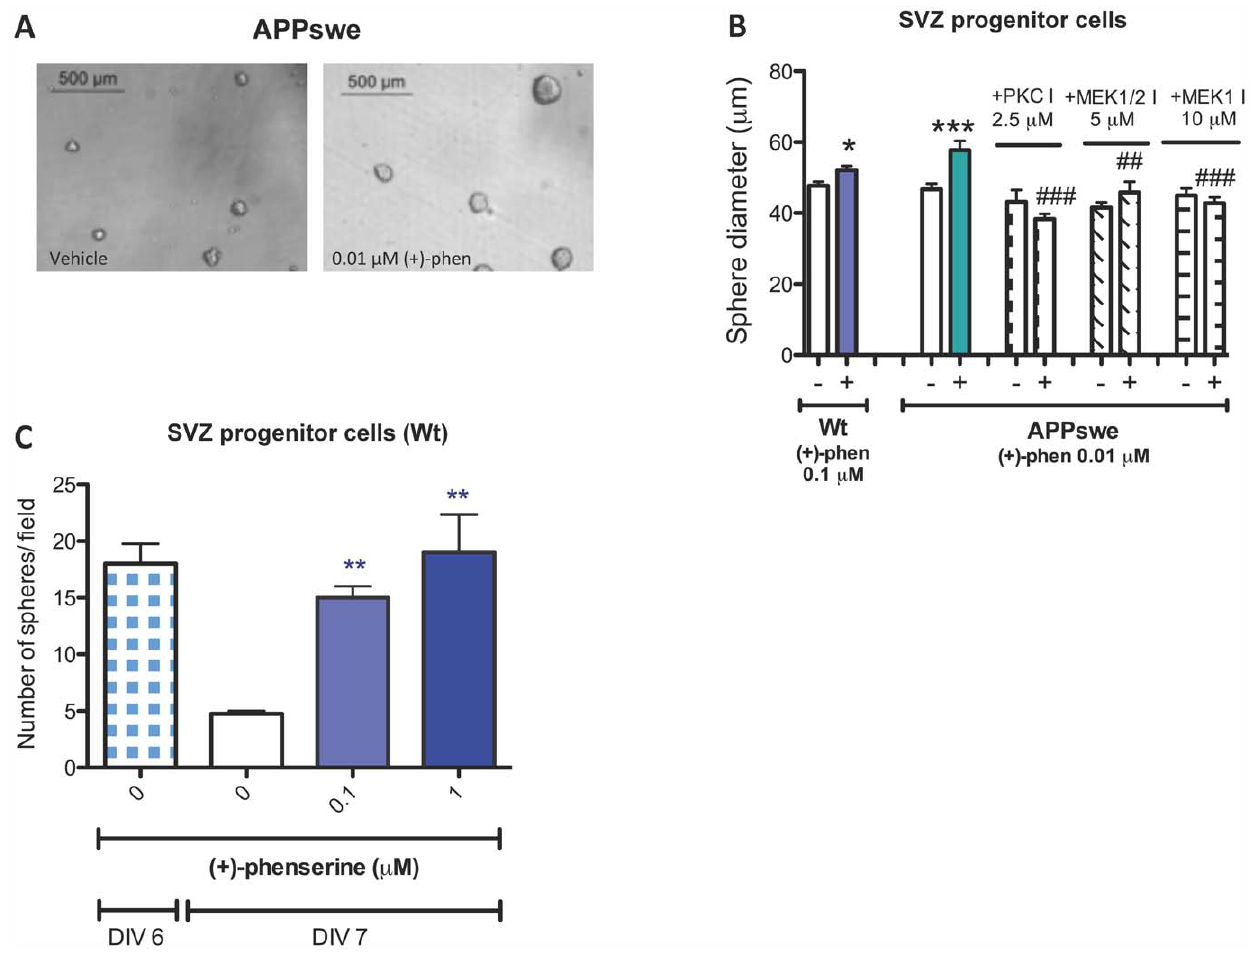
Figure 4. Enhanced subventricular progenitor cell survival and increased size of Tg2576 mouse neurospheres after ( + )-phenserine exposure. Representative images show SVZ progenitor cells exposed to vehicle or 0.01 m M ( + )-phenserine (A). Effects of the MEK1/2 inhibitor U0126, MEK1 inhibitor PD98059, and PKC inhibitor GF109203X on neurosphere size and neurosphere density in the presence of ( + )-phenserine are shown in (B). ***P , 0.001 compared to control samples without ( + )-phenserine or inhibitor, ## P , 0.01 and ### P , 0.001 compared to samples with ( + )- phenserine only (one-way ANOVA followed by Bonferronis multiple comparison post hoc test). The number of neurospheres composed of SVZ progenitor cells, isolated from the lateral (LGE) and medial (MGE) ganglionic eminence at embryonic day 13.5, were measured 7 days after exposure to 0.05, 0.1 and 1 m M ( + )-phenserine (C). *p , 0.05, **p , 0.01, and *** p , 0.001 compared to samples without ( + )-phenserine. Data were analysed with one-way ANOVA followed by Dunnetts post hoc test. Results are expressed as mean 6